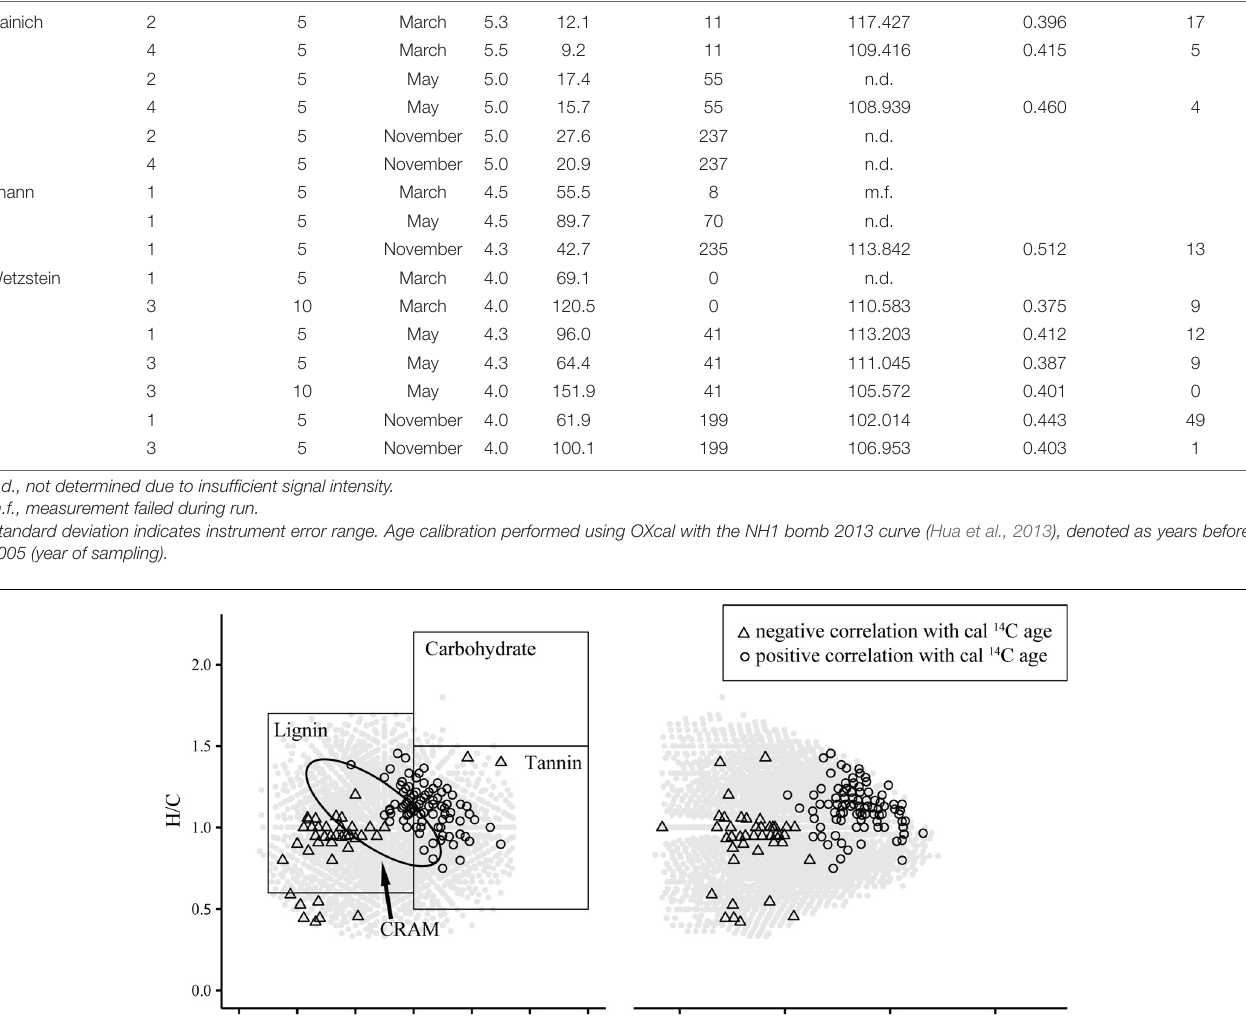
converged toward carboxyl rich alicyclic molecules